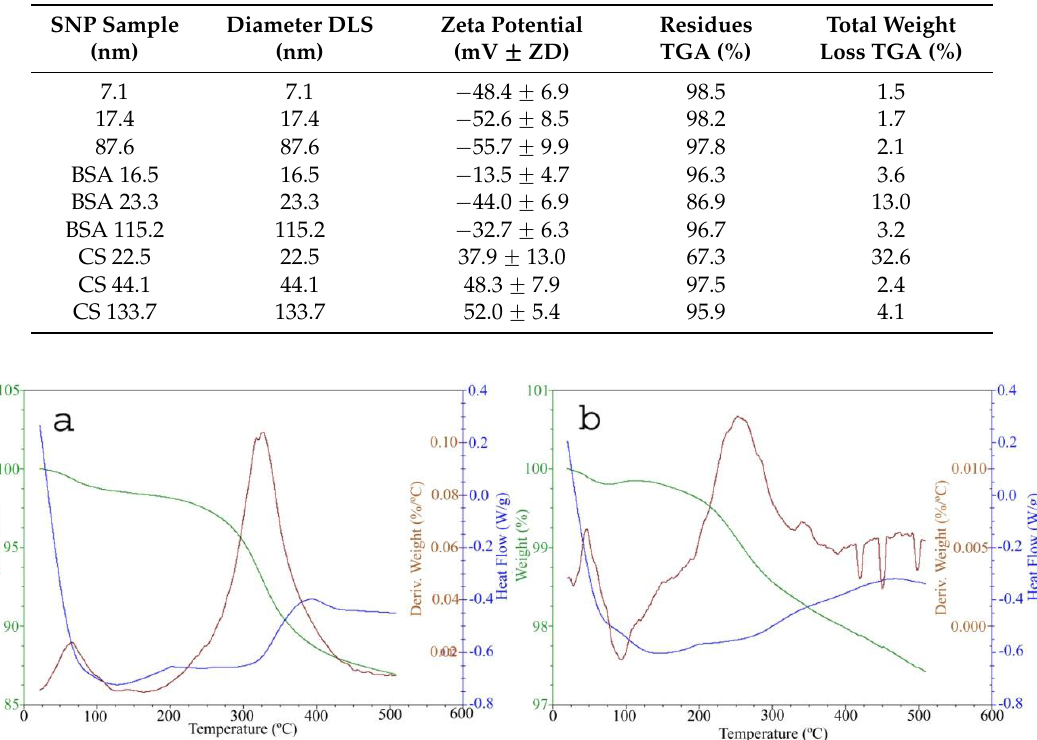
Table 1. Physical and thermal properties of the BSA and CS coated SNP.